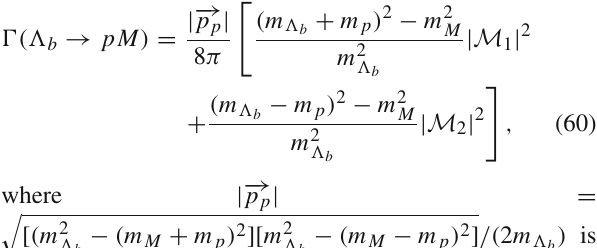
for the exponential model of the (cid:2) b baryon LCDAs, and → p (cid:3) ¯ ν (cid:3) ) = ( 14 ± 10 ) × 10 − 4 with (cid:3) = e , μ and B ((cid:2) b → p τ ¯ ν τ ) = ( 10 ± 7 ) × 10 − 4 for the free B ((cid:2) b